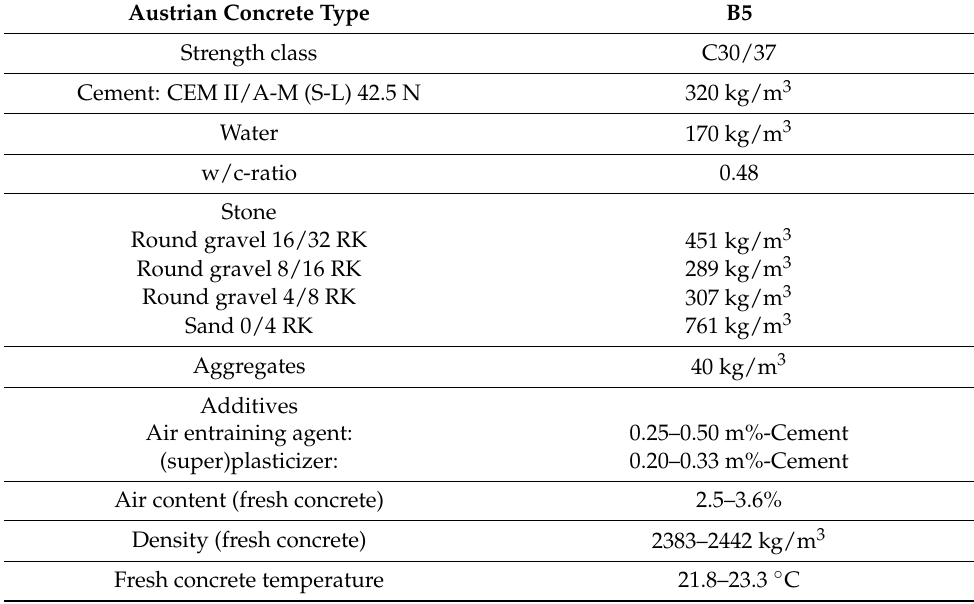
Table 2. Material properties of the concrete.